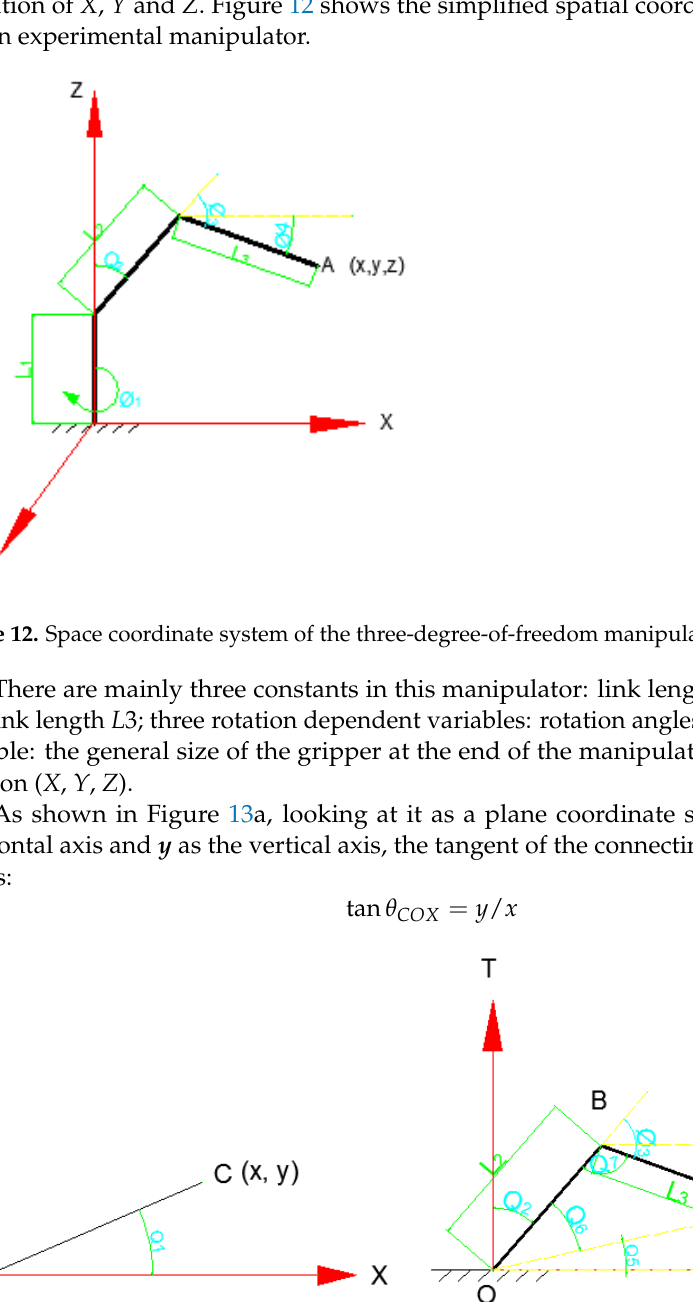
Figure 13. Coordinate system plane. ( a )XOY plane ( b )XOZ plane.